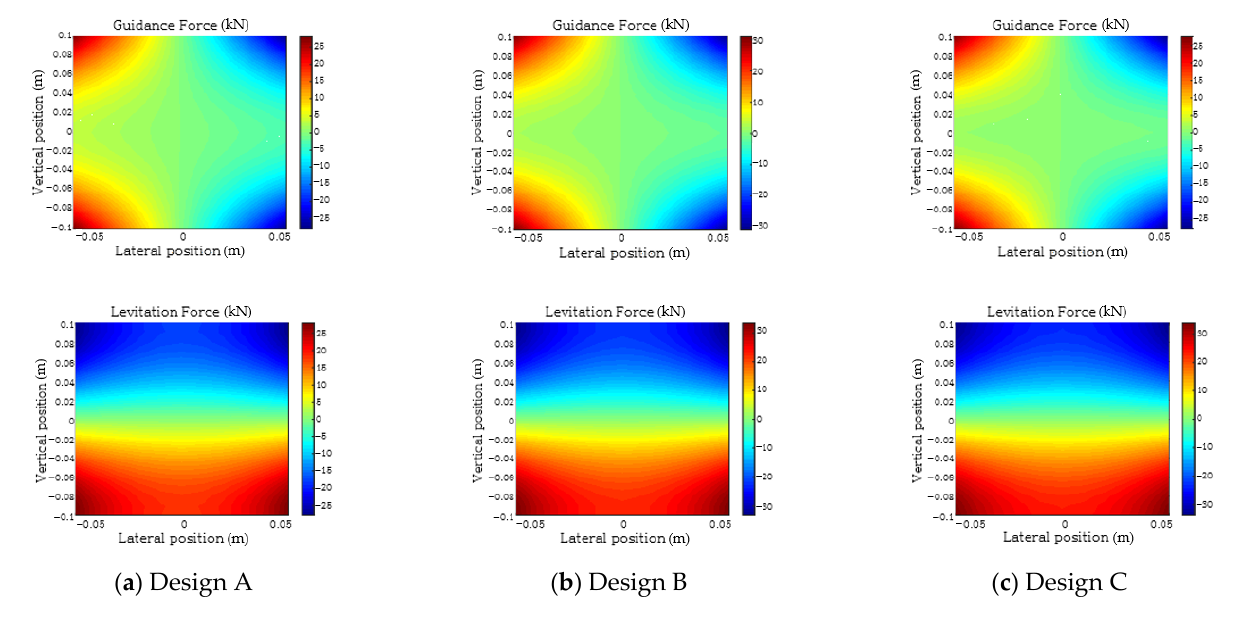
Figure 4. Distributions of the guidance and levitation forces.